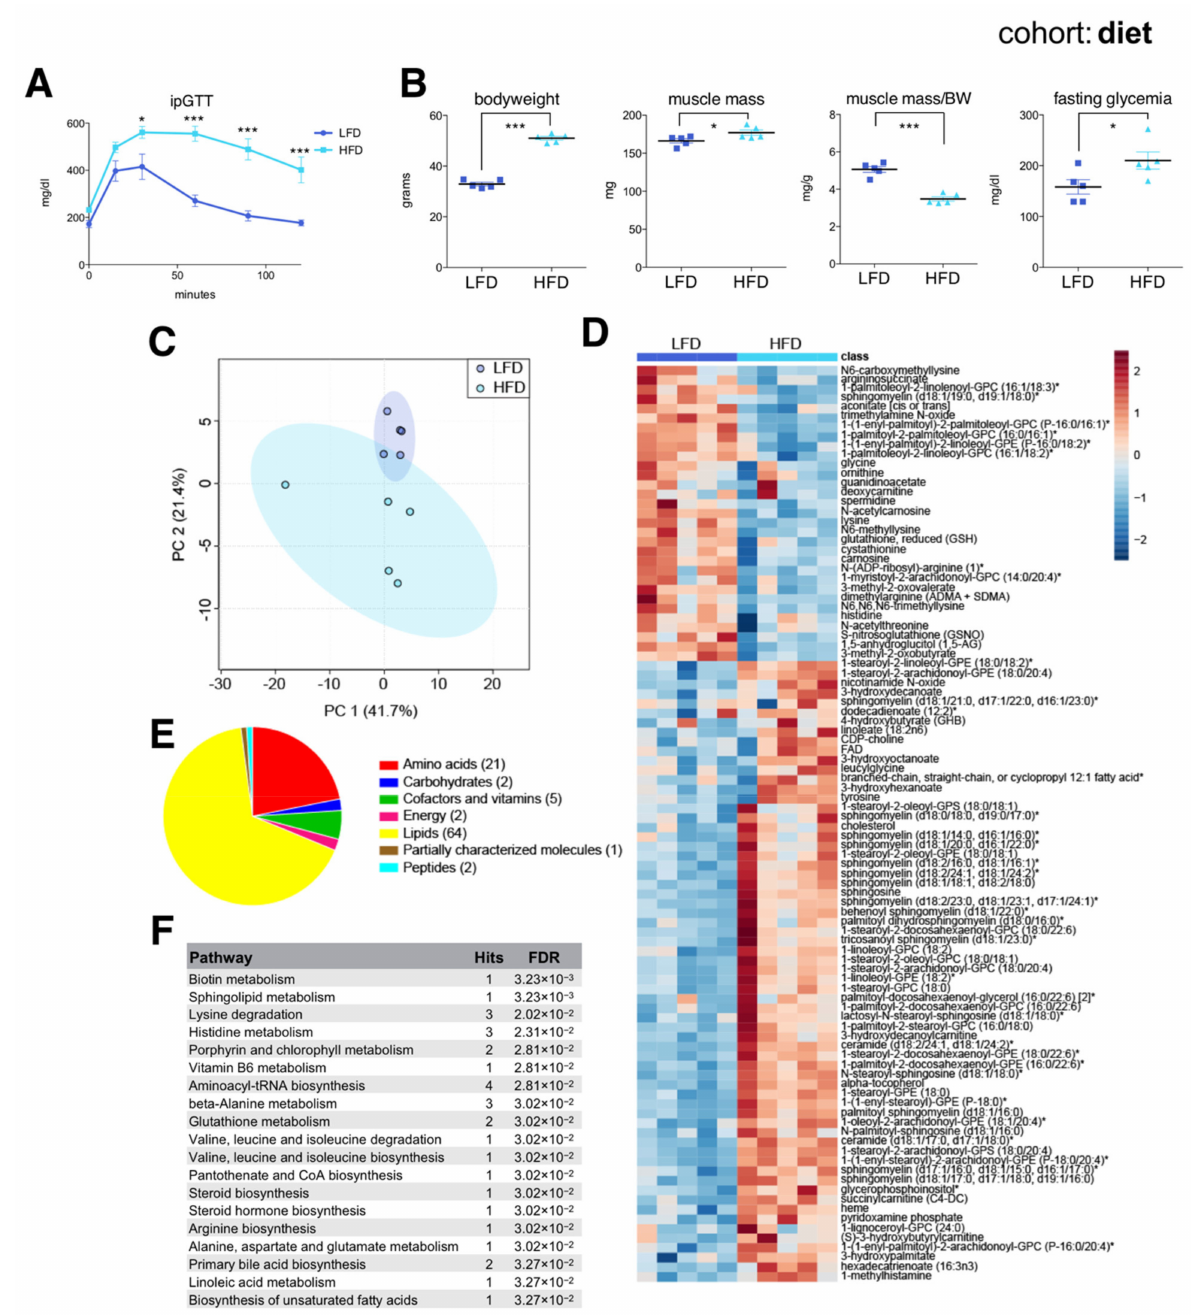
Figure 3. The skeletal muscle metabolome reflects changes associated with diet. ( A ) Intraperitoneal glucose tolerance test (ipGTT) performed one week prior to sac in the afternoon, after a 6 h fast in seven-month-old C57BL/6J male mice on a low fat diet (LFD) or a high fat diet (HFD) (mean ± SEM; n = 6; * p < 0.05, *** p < 0.001, 2-way ANOVA with Bonferroni correction; diet effect F = 26.60, p < 0.0004; time effect F= 39.06, p = 0.0001; diet × time interaction F = 7.82, p < 0.0001). ( B ) Bodyweight, muscle weight ( gastrocnemius ), muscle weight relative to bodyweight (BW), and glycemia after a 4 h fast (mean ± SEM; n = 5; *** p < 0.0001, * p < 0.05, Student’s t -test). ( C ) Principal component analysis of the entire metabolomics data set. ( D ) Heatmap of metabolites selected by random forest shown for individual samples. Metabolites labeled with an asterisk have not been confirmed with a standard, but we are confident of their identity. ( E ) Classification of random forest selected metabolites according to metabolite class. The number of metabolites per class is shown in parentheses. ( F ) Quantitative enrichment analysis showing the top enriched pathways with FDR < 0.05 based on the metabolites selected by random